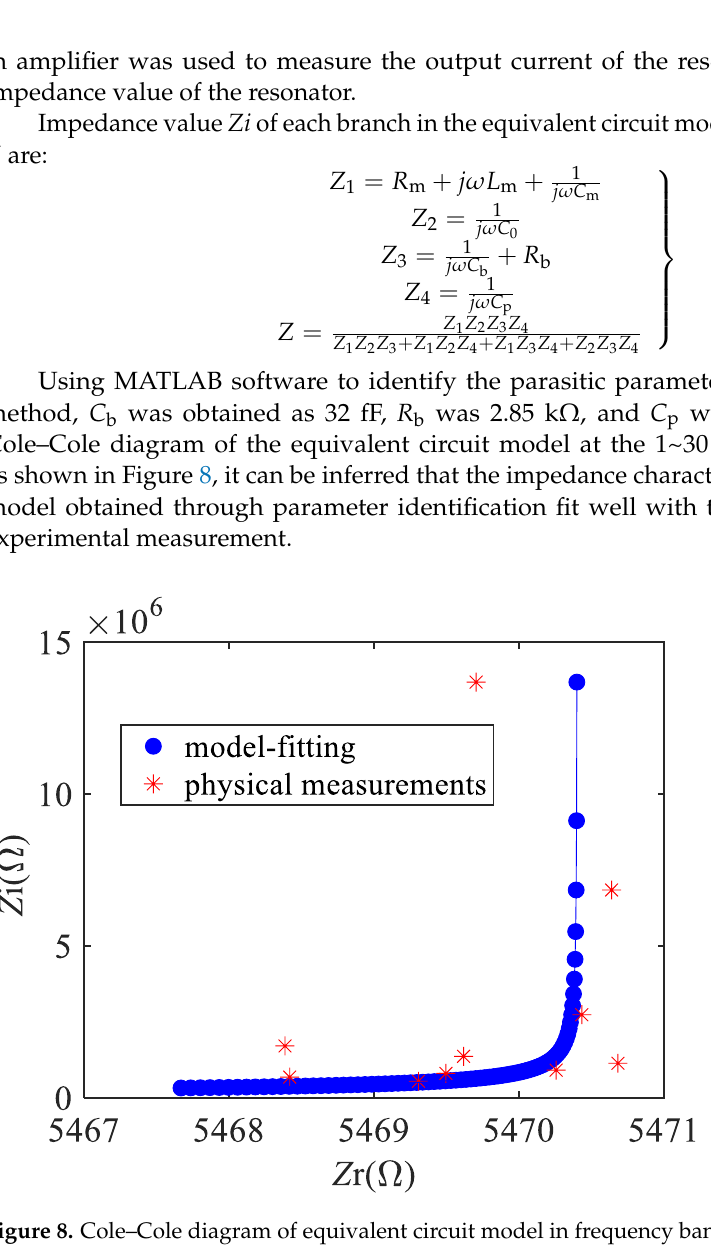
Figure 8. Cole – Cole diagram of equivalent circuit model in frequency band 1~25 MHz. Figure 8. Cole–Cole diagram of equivalent circuit model in frequency band 1~25